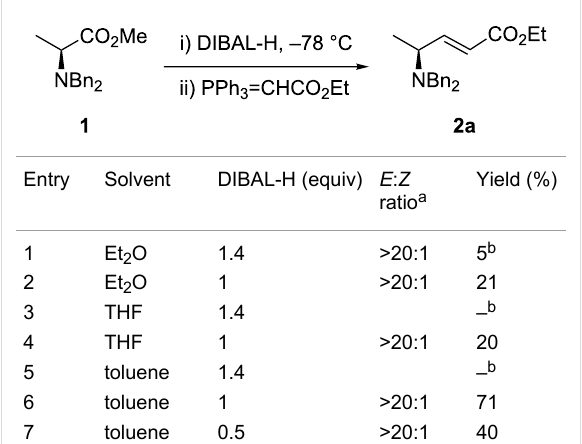
Table 1: Screening of the reaction conditions for the one-pot tandem